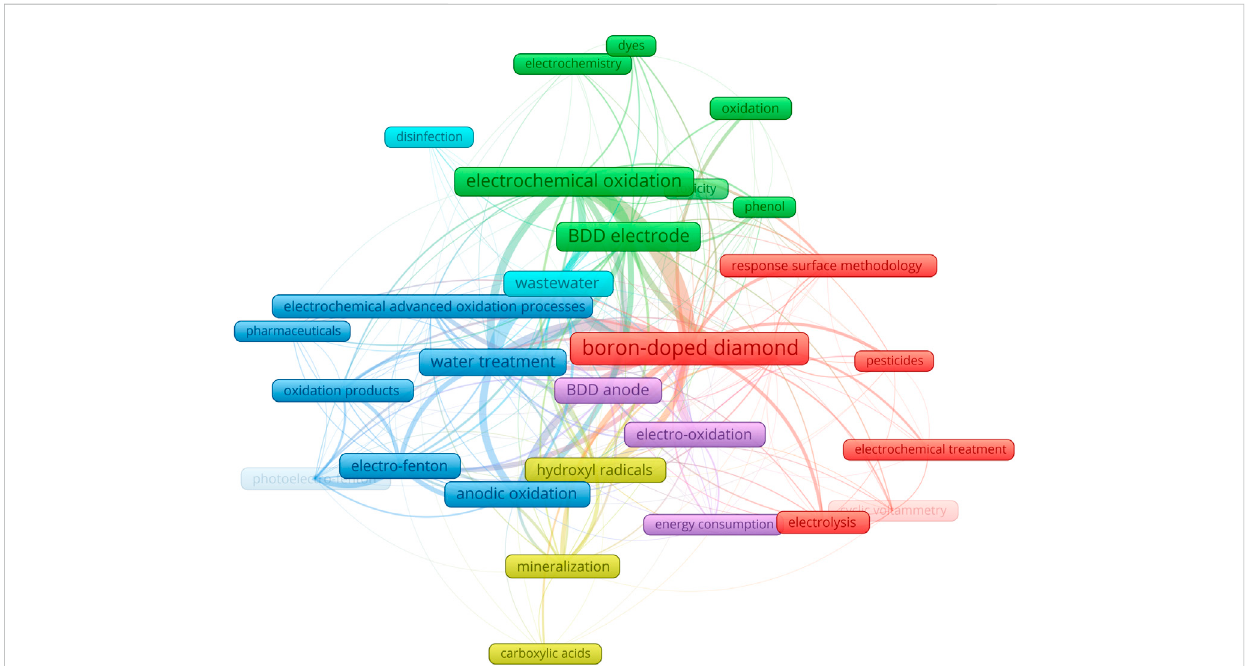
FIGURE 4 Keywords co-occurrence network (minimum of 10 occurrences) representation of the trends on the application of BDD anodes in the degradation of contaminants and corresponding relationship within the main themes, sorted in six clusters represented in different colors, based on the Scopus database and VOSviewer as the bibliometric network graph software (source: the authors).